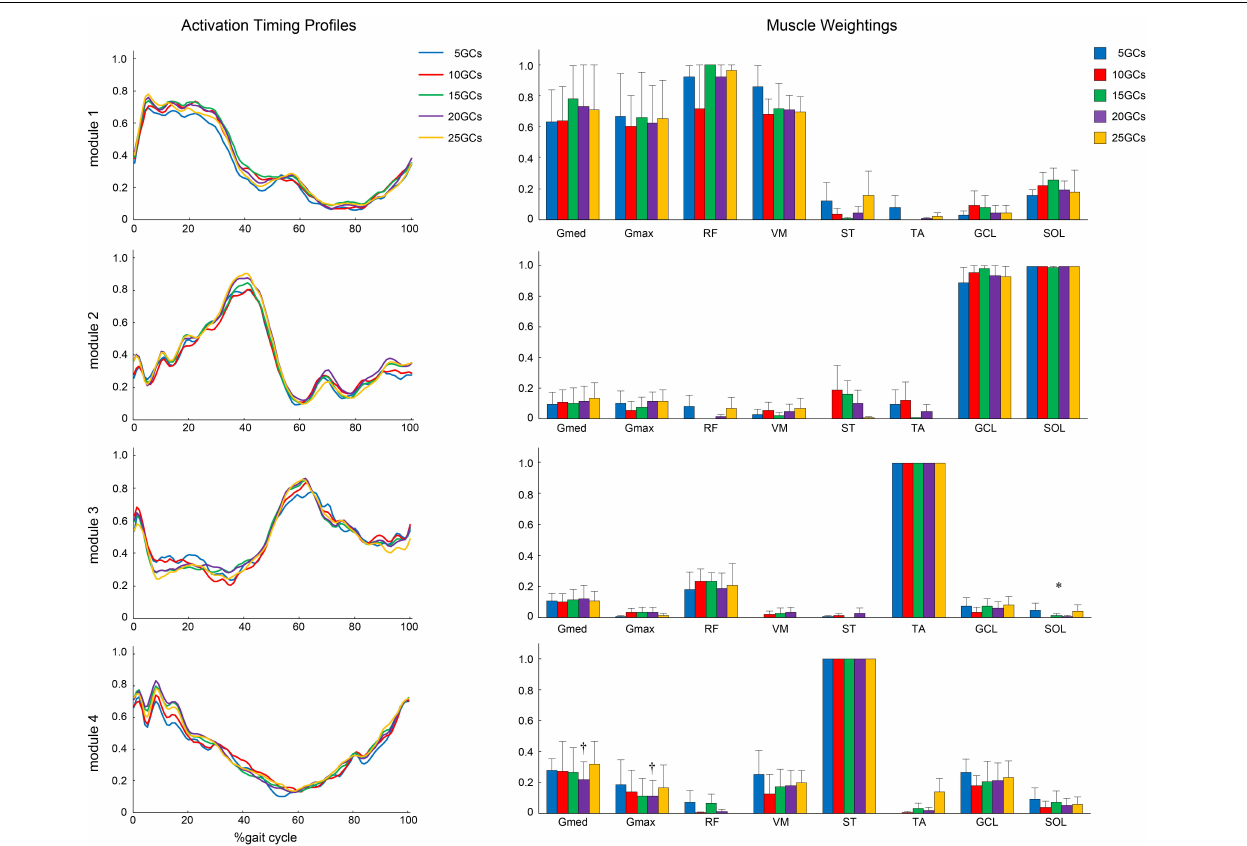
FIGURE 5 | The activation timing profiles and muscle weightings of assuming four modules. The effect of the different GCs when the LPF was 10 Hz. Activation timing profiles are shown as the conditional mean. The bars of muscle weightings indicate the conditional median, and the error bars indicate the median absolute deviations. Significant differences are marked with ∗ ( p < 0.05 in the Friedman test only) and † ( p < 0.05 in the Friedman test, and p < 0.0125 when comparing the reference condition, 25 GCs in the Bonferroni-corrected Wilcoxon signed-rank sum test). LPF, low-pass filter; GC, gait